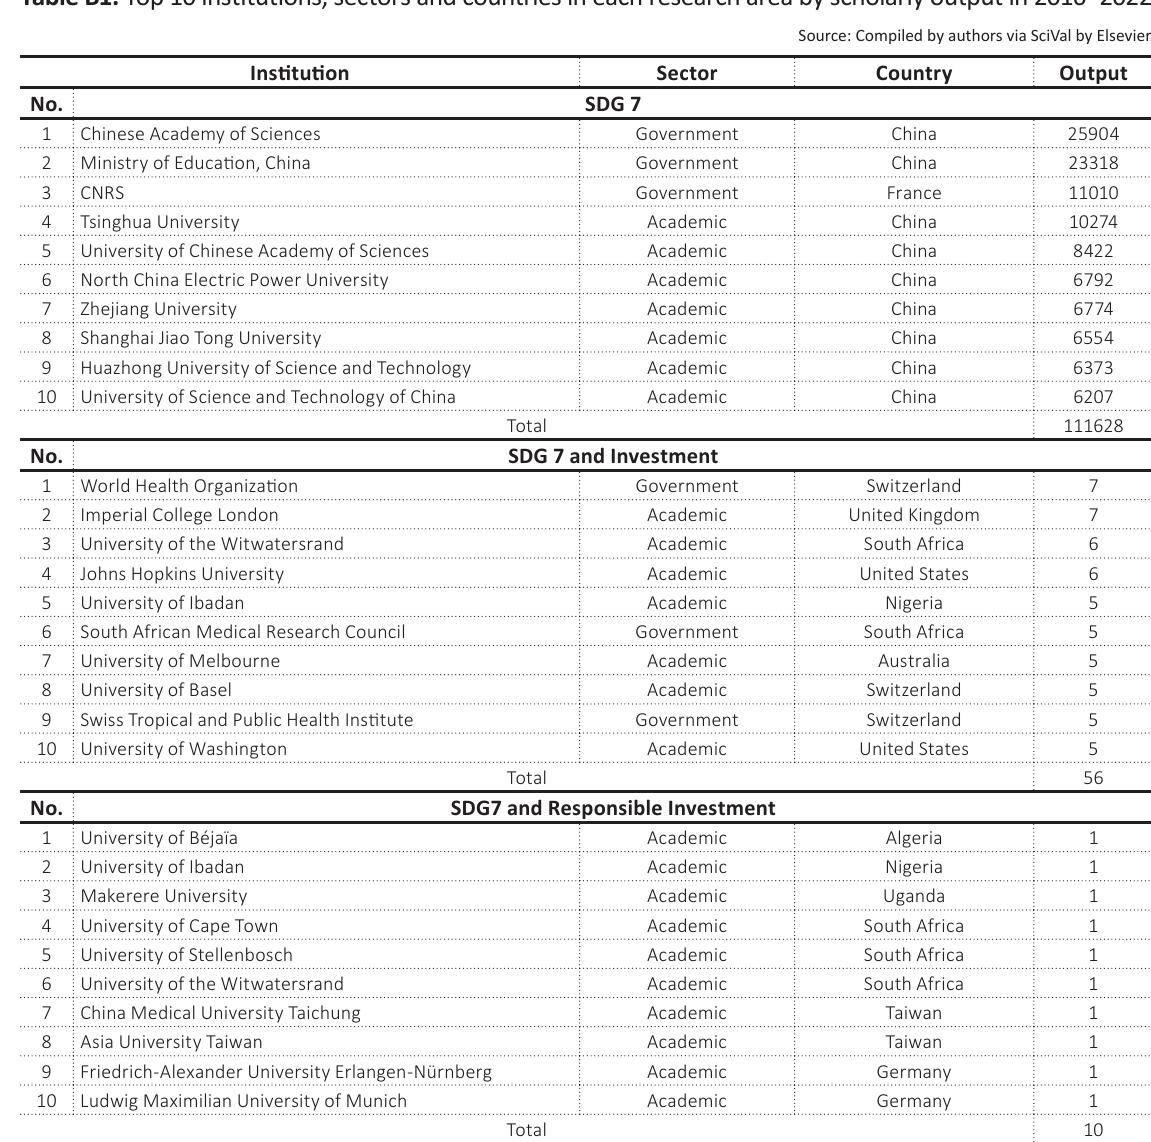
Table B1. Top 10 institutions, sectors and countries in each research area by scholarly output in 2016–2022